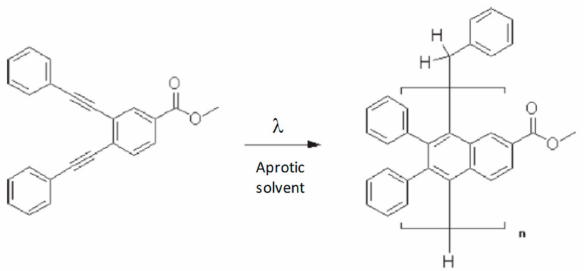
Figure 8. Illustration of the structure of photo-Bergman cyclization products obtained after UV irradiation of an enediyne compound in an aprotic solvent. Reprinted from [38] with